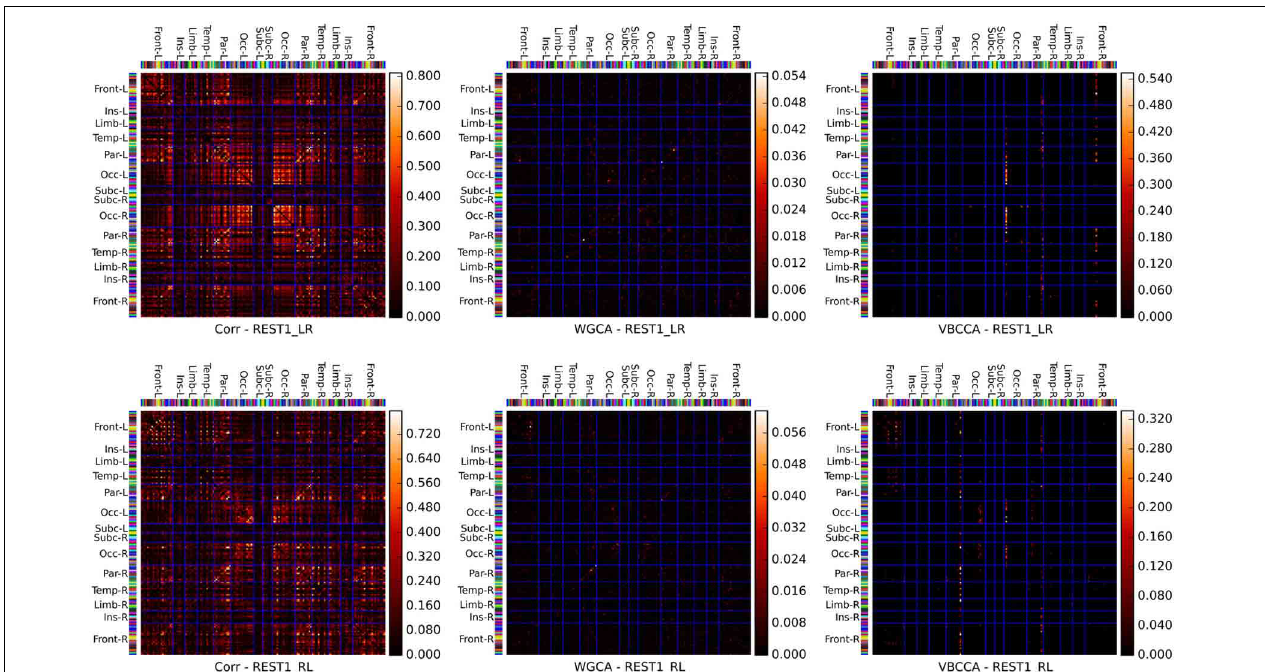
FIGURE 10 | Connectivity matrices showing the absolute correlation coefficient (Corr), Wiener–Granger causality (WGCA), and causality estimated by the proposed method (VBCCA). We use the same parcel grouping and order as in Irimia et al. (2012), which groups the parcels into cortical lobes, i.e., frontal (Front), insular (Ins), limbic (Lim), temporal (Temp), parietal (Par), occipital (Occ), and subcortical (Subc). The “ − L” and “ − R”